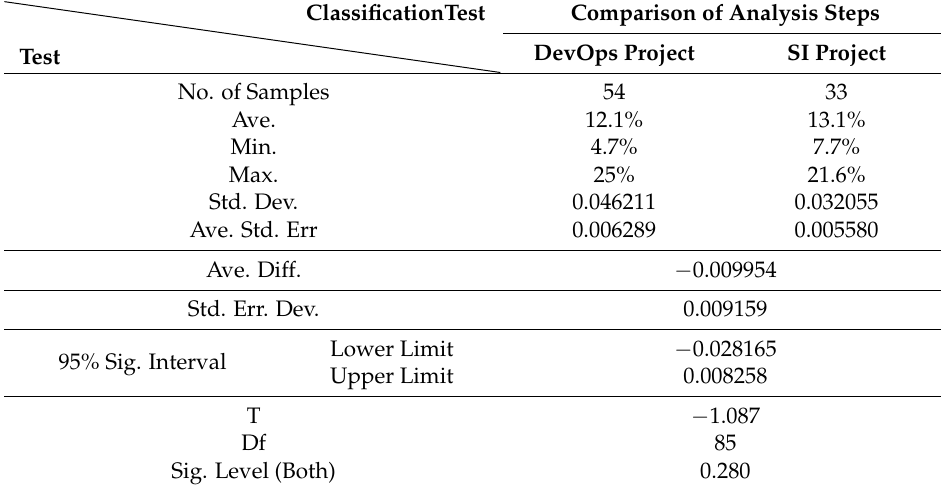
Table 15. Test results of workforce input rates in each life cycle.